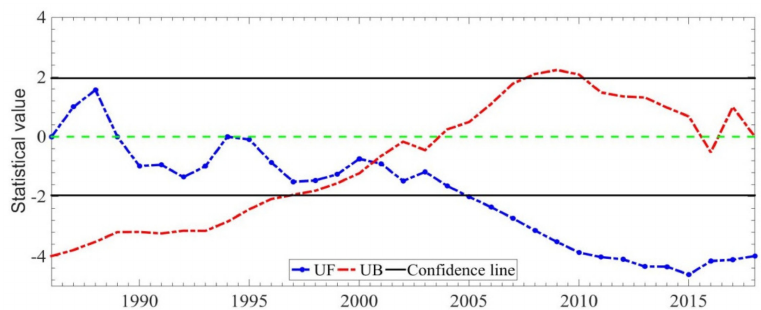
Figure 9. The trend of the total annual discharge of the Khogshin Orkhon River, which is an inflow of the Ugii Nuur Lake (where UF and UB are parameters of the change, UB = − UF).